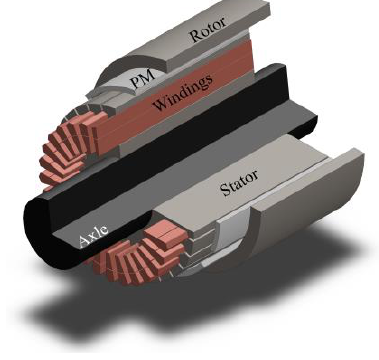
Figure 1. 3D-View of an OR-SPMSM.